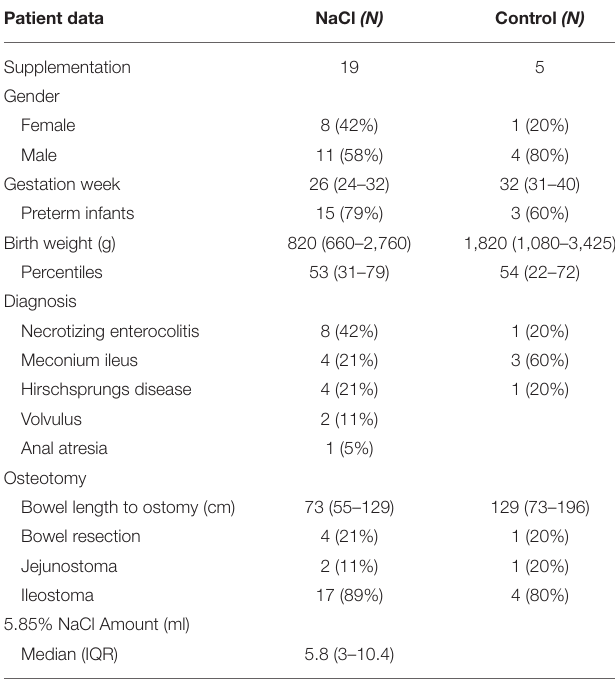
TABLE 1 | Summary of demographic and clinical patient